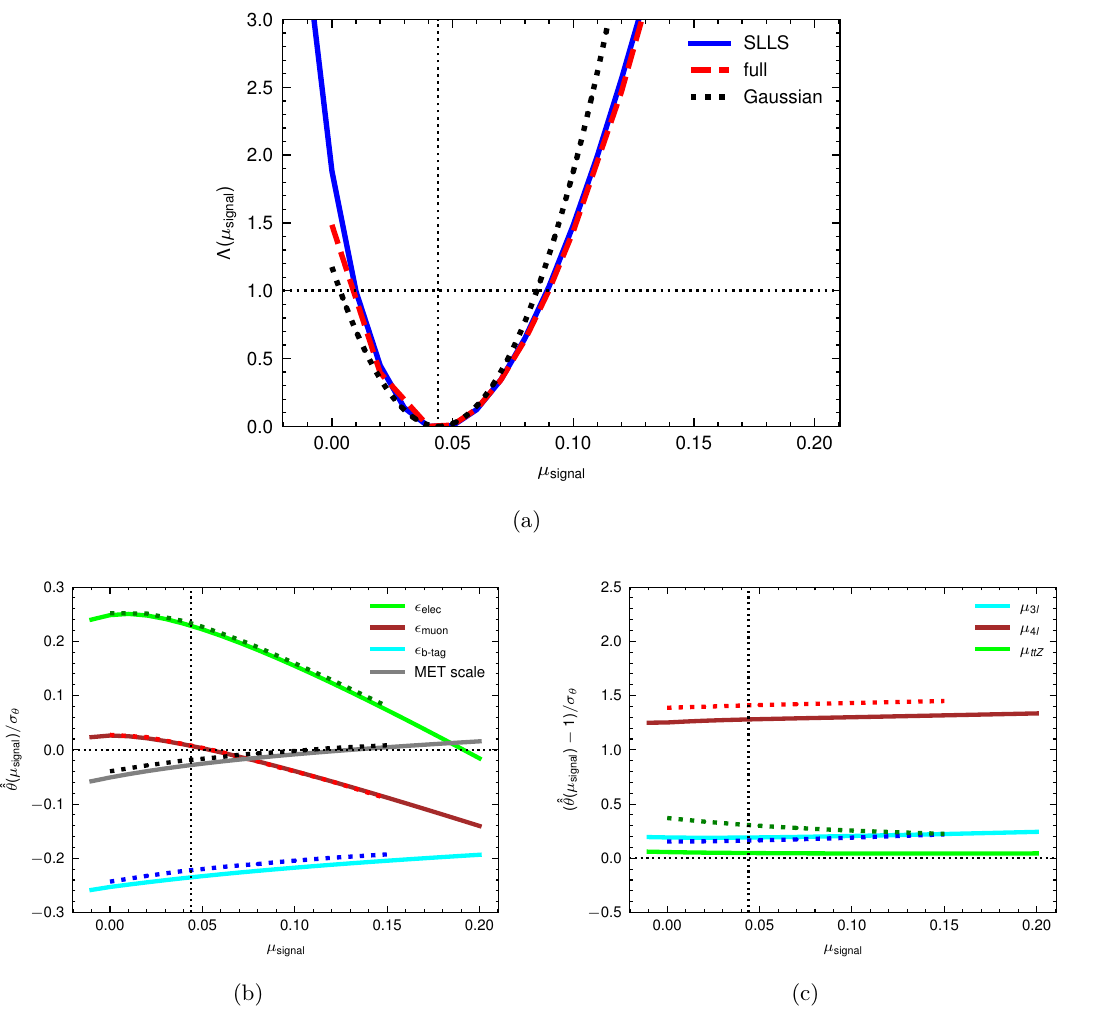
Figure 4 . Comparison between the SLLS simplified model (solid lines) and the full model (dashed lines) for (a) the PLR Λ( µ ) as a function of µ , (b) the profiled values of selected NPs signal signal describing systematic uncertainties and (c) the profiled values of NPs describing scale factors applied to the normalization of the main analysis backgrounds. The profiled values are shown as deviations from the nominal value of the parameters (0 for systematic uncertainties, 1 for background scaling factors), divided by the uncertainty on the parameter in the full-model fit to the observed data with free µ . The SLLS results are computed using the fastprof tool, and the full-model results with signal the pyhf tool. Panel (a) also shows the PLR scan computed using a Gaussian model as described in the